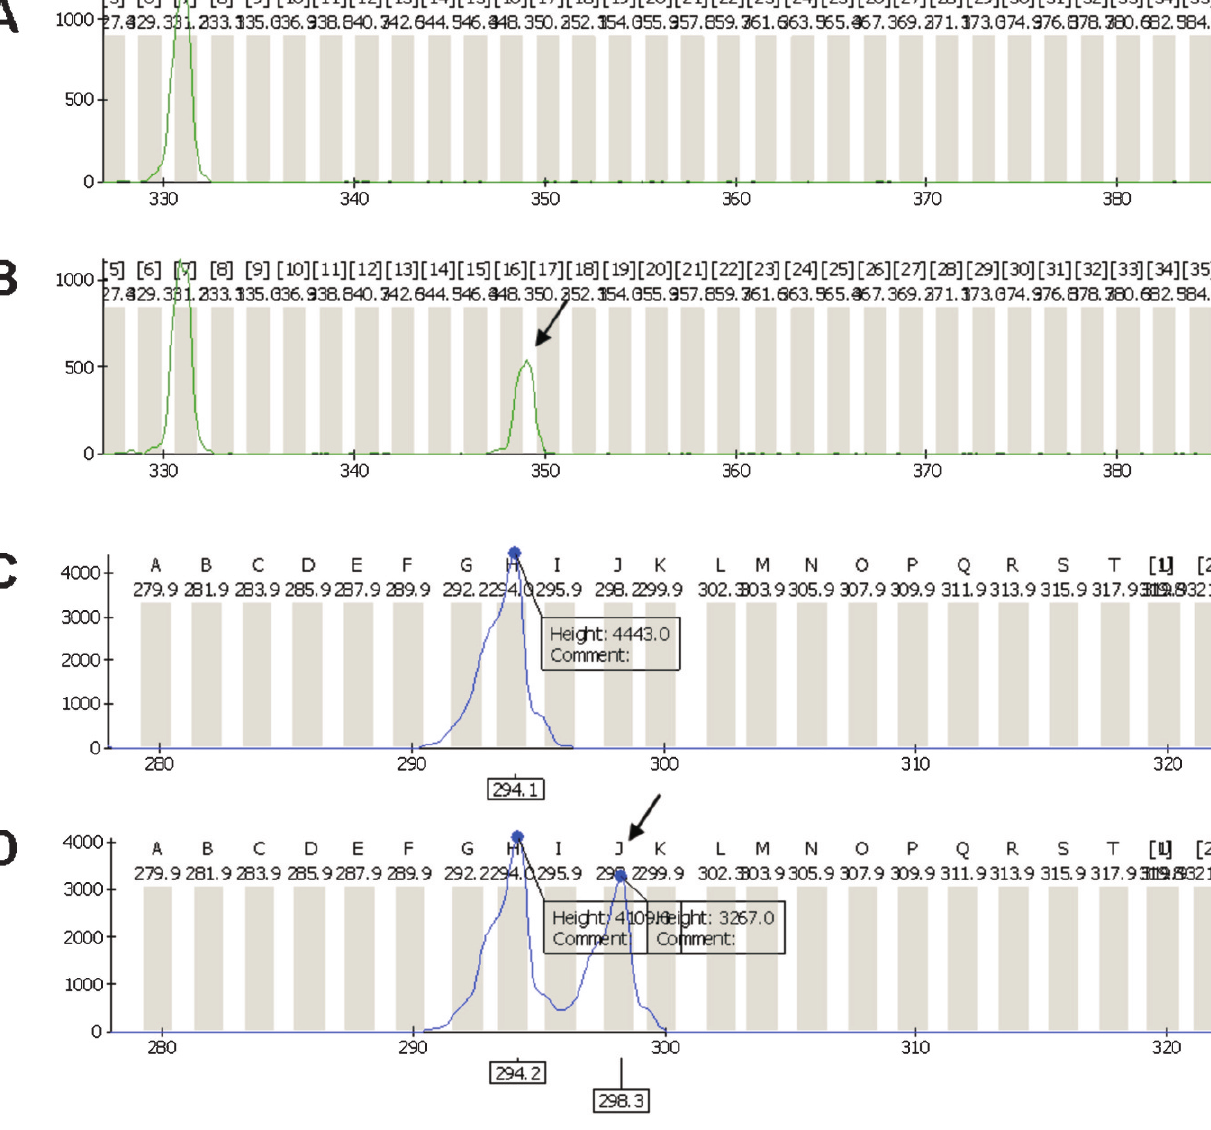
Figure 2 - Fragment analysis of FLT3 -ITD and NPM1 mutations . Representative fragment size analysis of a MDS patient with wild-type alleles for FLT3 (A), an AML patient with the FLT3 -ITD mutation (B), an MDS patient with wild-type NPM1 (C) and an AML patient with a mutation in exon 12 of NPM1 (D). The arrows indicate the presence of the